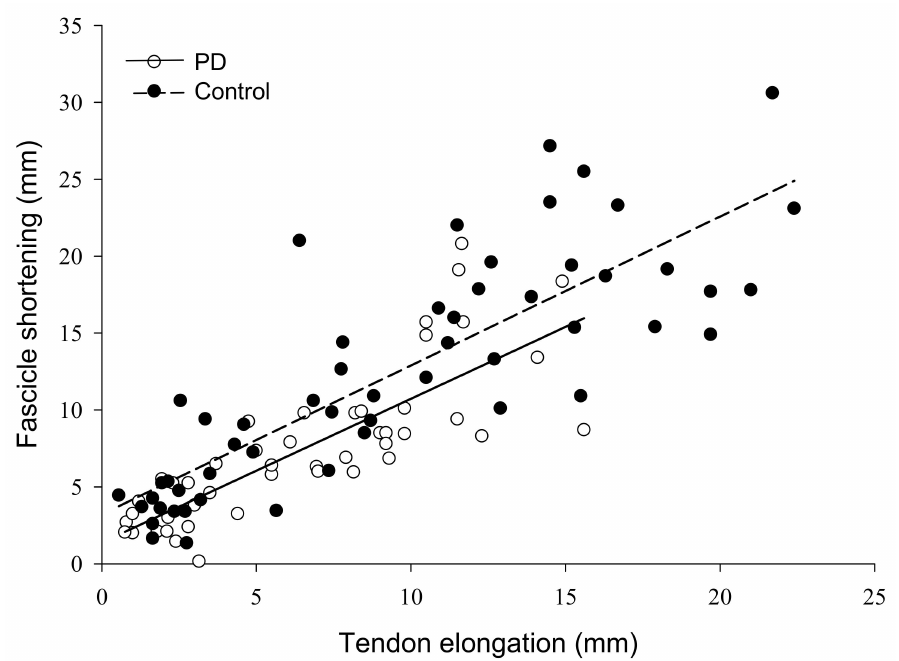
Figure 4. Relationship of muscle fascicle shortening to tendon elongation in persons with Parkinson’s disease and controls. The amount of muscle fascicle shortening was a significant predictor of tendon elongation in both groups, explaining 43% of the variance in tendon elongation for persons with PD, and 60% of the variance in controls ( p < 0.001). PD, Parkinson’s disease; mm,